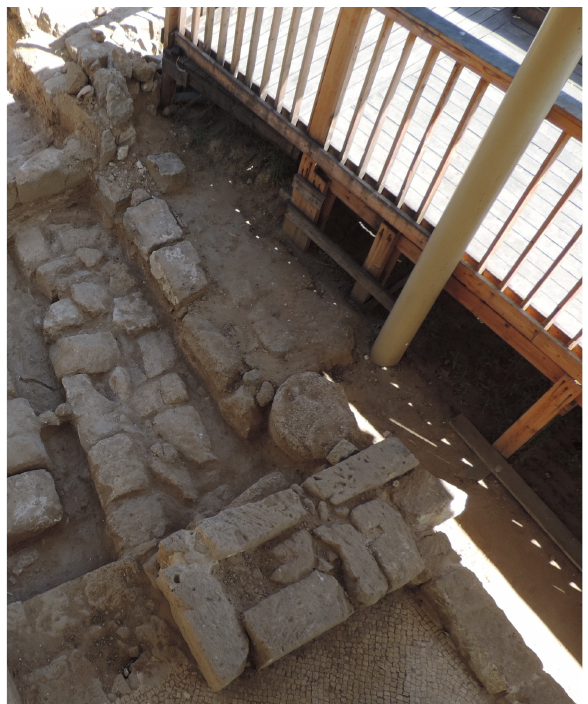
Figure 7. Juxtaposition of structure and access for visitors with the excavations